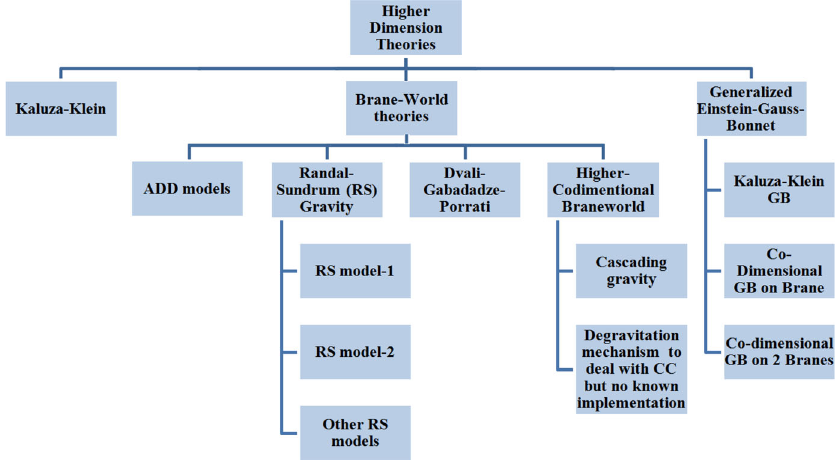
Fig. 14 Higher-dimension modified gravity